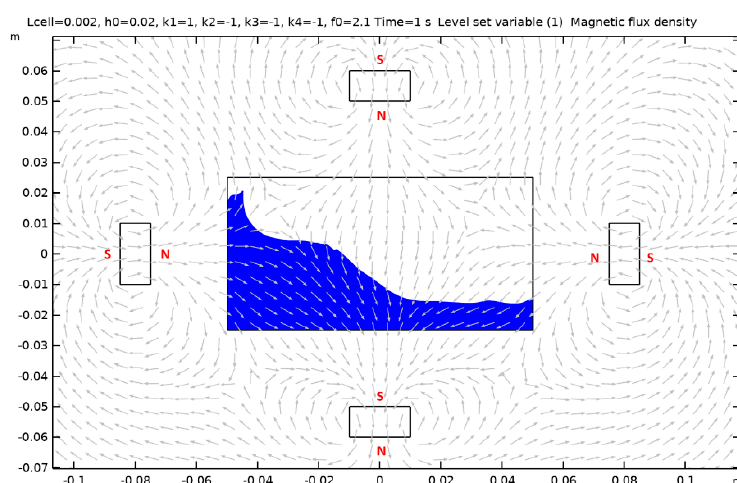
Figure A7. Case 8.